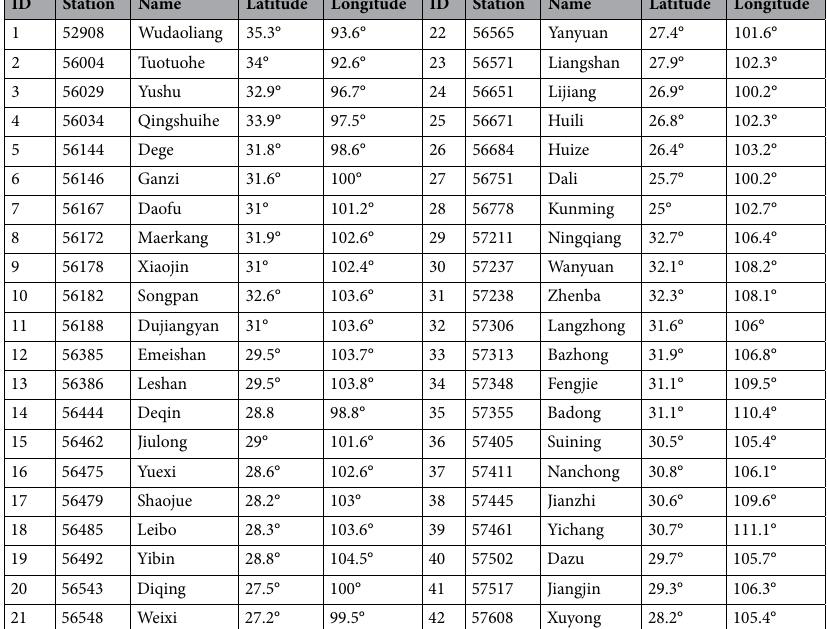
Table 5. Meteorological stations used for the correction performance